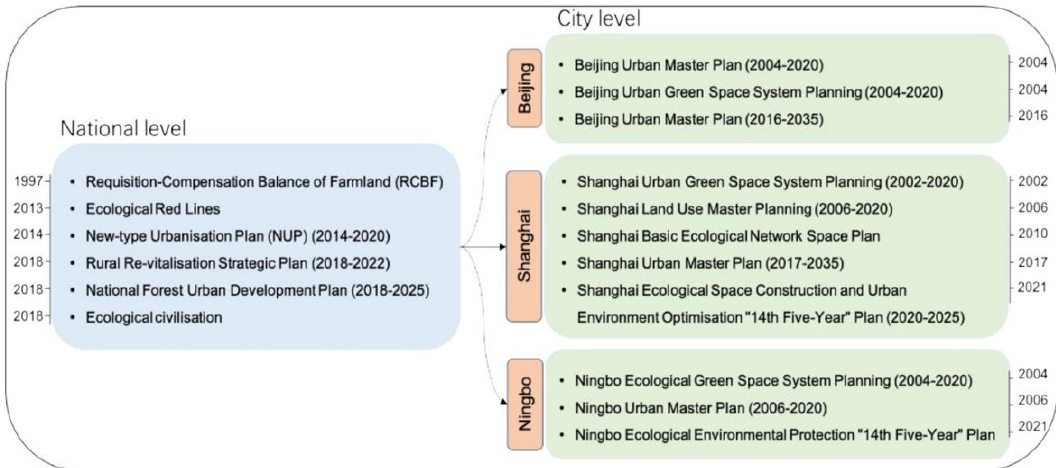
Figure 3 . Policy evolution in China, on urban-rural interactions, from 1997 to 2021. To the left, the evolution is explained at the national level; to the right, it is exemplified in more detail, for the three urban areas of the REGREEN project, at city level.